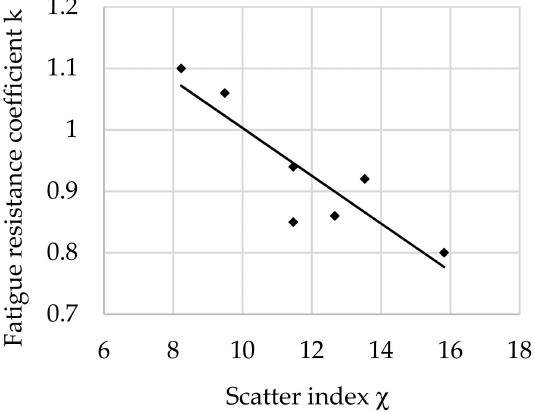
Figure 6. The relationship between the fatigue resistance coefficient and scatter index of structural steel hardened and tempered at 400 ◦